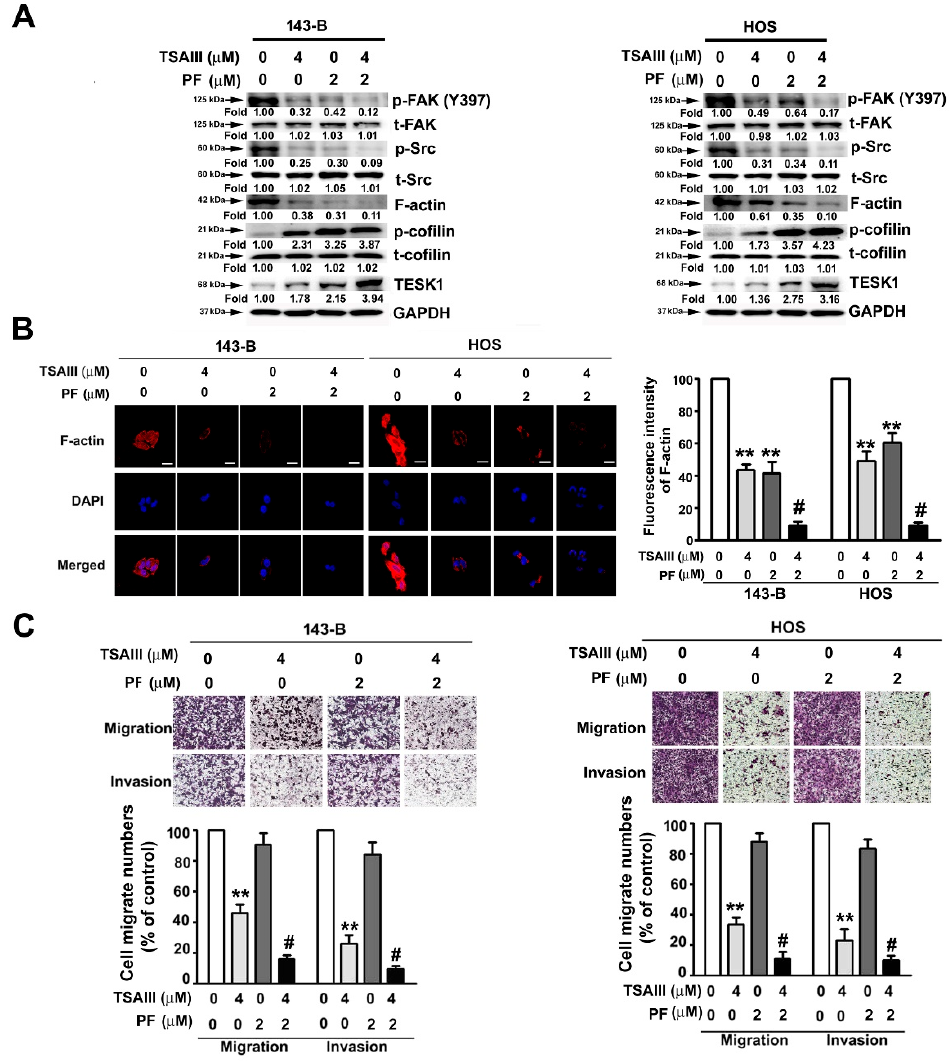
Figure 5. Synergistically inhibitory effect of TSAIII and PF on migration and invasion of human osteosarcoma cells. ( A ) Human 143-B and HOS osteosarcoma cells were treated with various concentrations of TSAIII (0 and 4 µ M) and/or PF (0 and 2 µ M) and then harvested to detect the expression and activation of cytoskeletal-related proteins through immunoblotting. Glyceraldehyde-3-phosphate dehydrogenase (GAPDH) was used as the internal control. ( B ) Using immunofluorescence analysis, the expression of cytoskeletal F-actin was observed in human 143-B and HOS osteosarcoma cells. ( C ) The migration and invasion abilities of human 143-B and HOS osteosarcoma cells were measured after treatment with TSAIII in the presence or absence of PF for 24 h. ** p < 0.01 versus control; # p < 0.05 versus treatment with PF alone (mean ± standard error, n = 3). PF denotes PF-573228 (focal adhesion kinase inhibitor). Scale bar: 50 μ m.